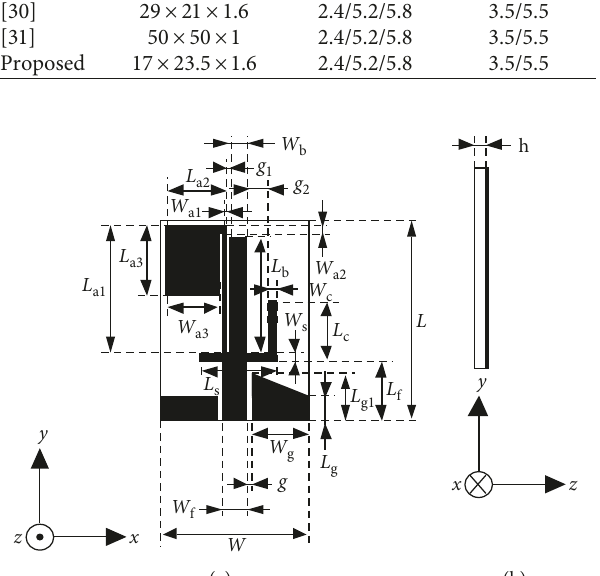
Figure 1: The proposed WLAN/WiMAX triband antenna: (a) top view and (b) side